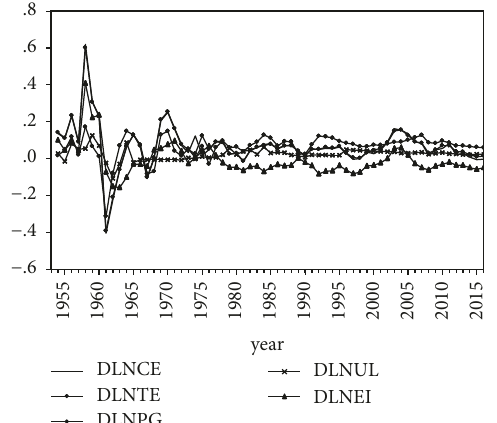
Figure 4: Times histories of first difference